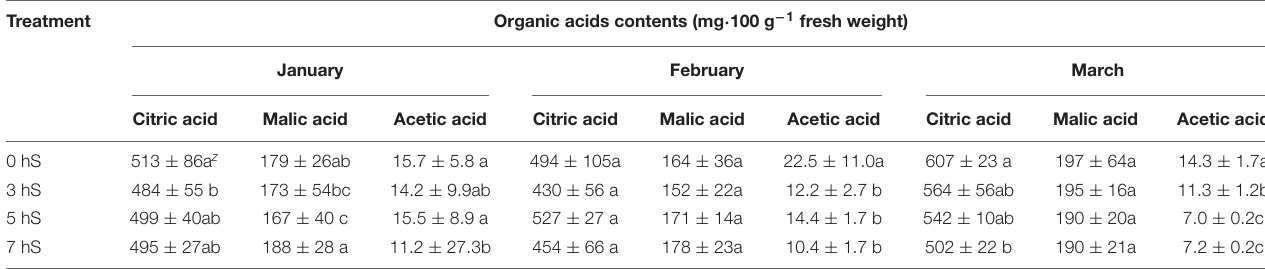
TABLE 4 | Organic acid contents of strawberry ( Fragaria × ananassa ) fruit grown under various light intensity conditions in a smart greenhouse.